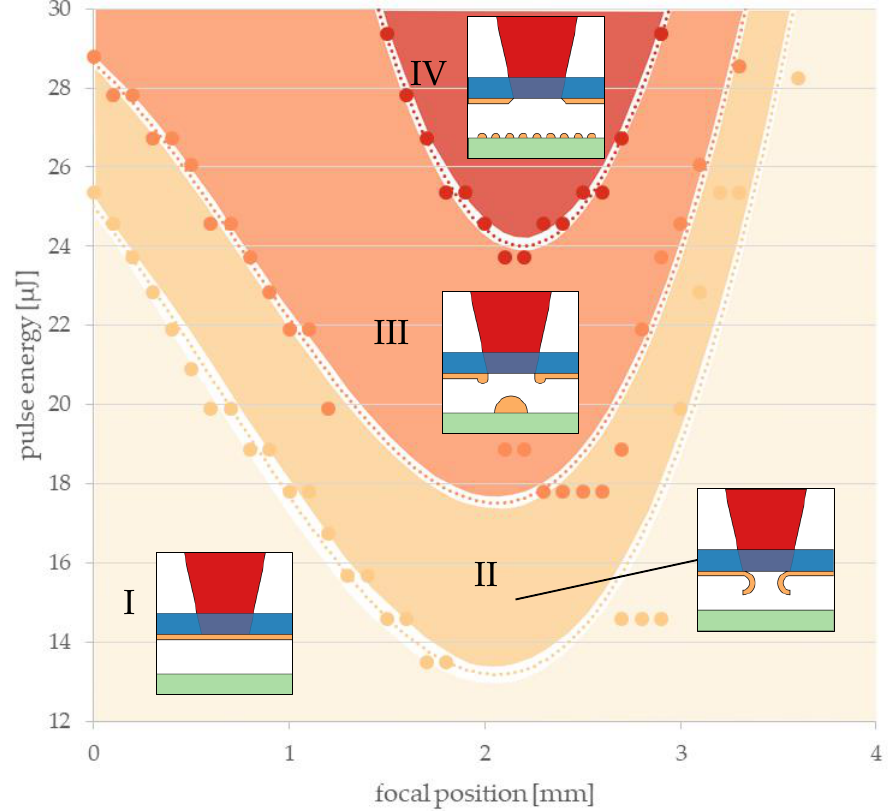
Figure 5. Exemplary result of the microscopic evaluation of test patterns, which were printed using LIFT with a gold donor layer of 291 nm and a z-height of 245 µ m. Data points represent observed transitions that depended on the pulse energies and focal positions. Dotted lines represent polynomial approximations of the data points marking transitions. Four different regimes were identified and are separated by these lines: (I) donor is not affected; (II) donor is affected, but no transfer; (III) LIFT leads to voxel formation; (IV) evaporation and deposition as random small particles (fragments of voxels).